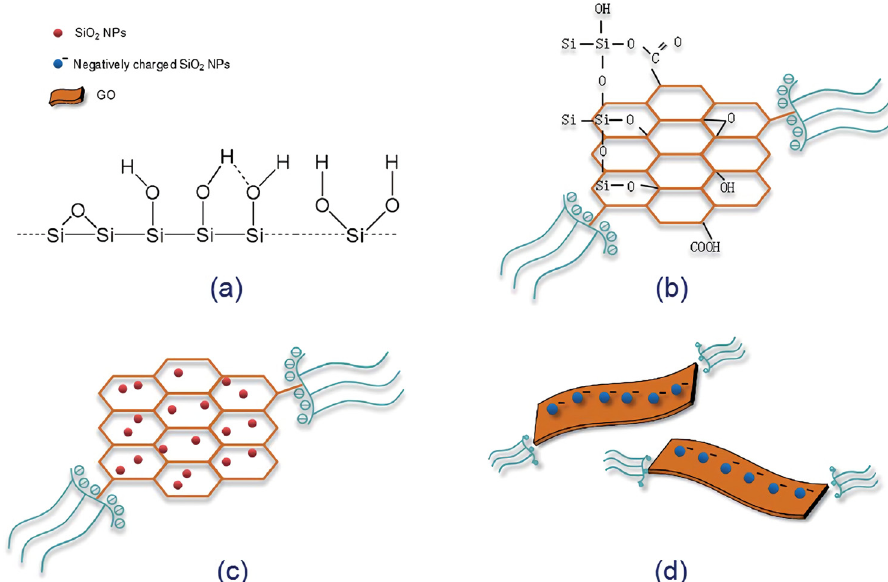
Figure 20: Scheme showing the dispersion mechanism of SiO 2 NPs on GO surface: ( a ) the surface structure of SiO 2 NPs; ( b ) the covalent interaction between Si – OH and functional groups of GO nanosheets; ( c ) the uniformly dispersed SiO 2 NPs on GO nanosheets and ( d ) the electrostatic repulsion between GO nanosheets covered with negatively charged SiO 2 NPs [ 134 ] .